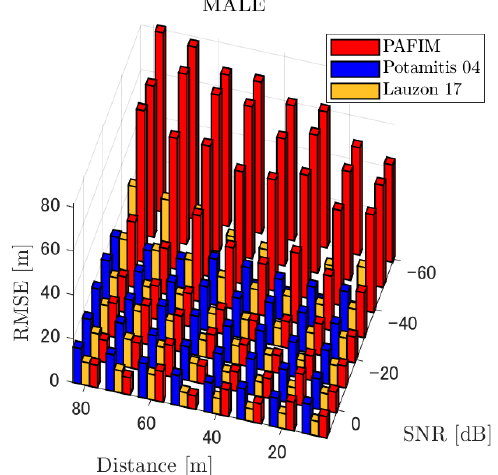
Figure 16. RMSE of tracking a randomly moving sound source emitting male voice.